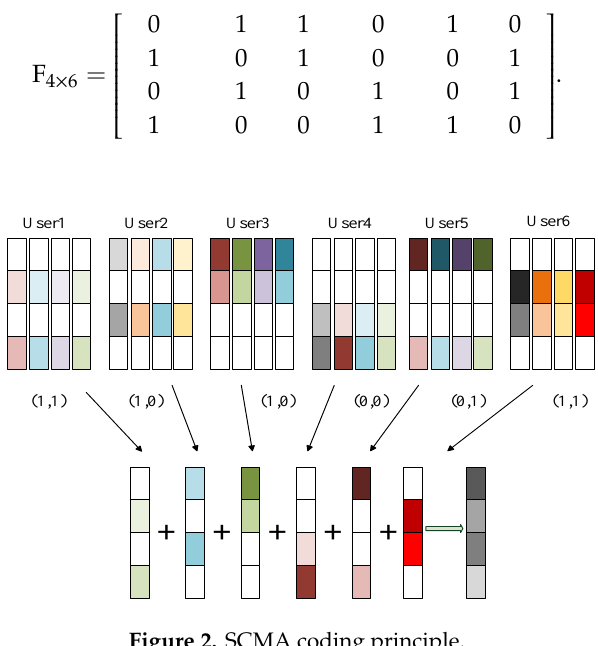
Figure 2. SCMA coding principle.